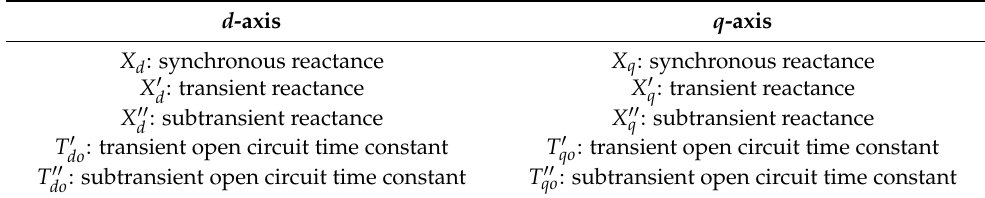
Table 2. Generic parameters of a synchronous machine in dq-reference frame. d -axis q